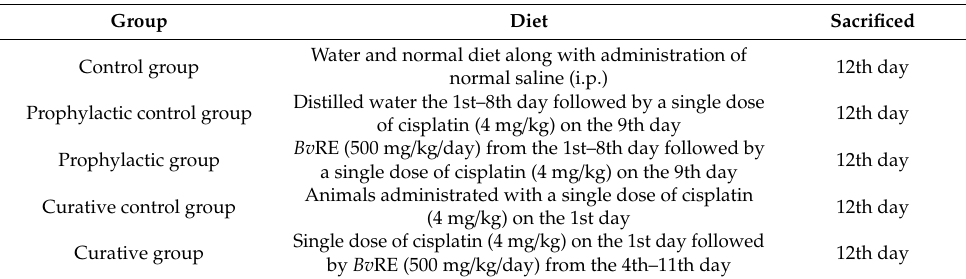
Table 4. Dose regimen of cisplatin and Bv